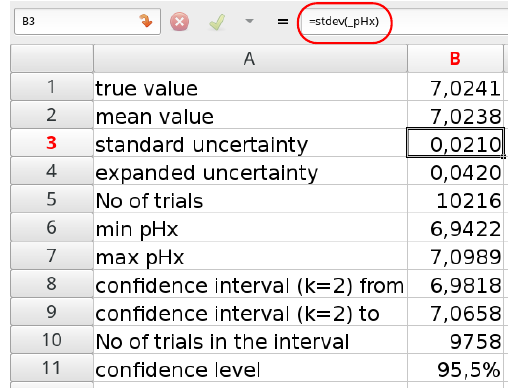
Figure 5. Output data calculated in